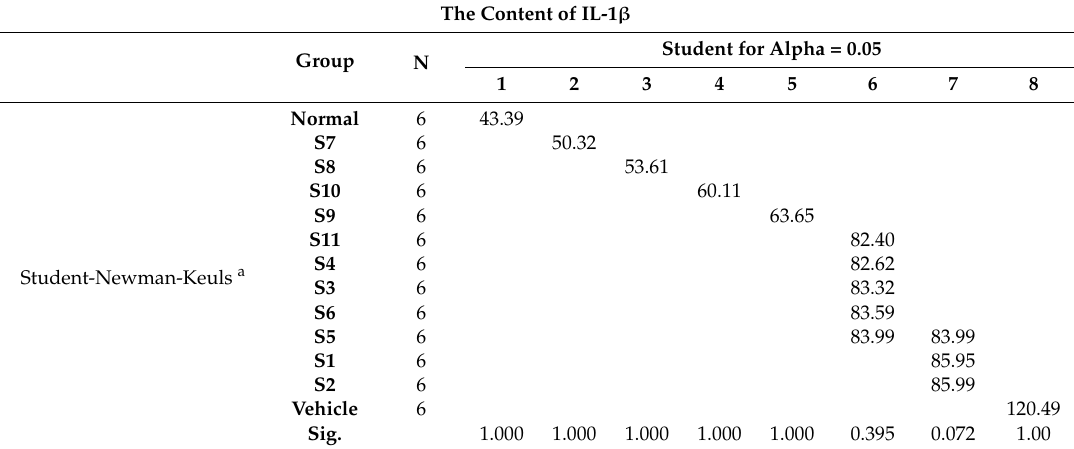
Table 5. Multiple comparison SNK test results of IL-1 β .